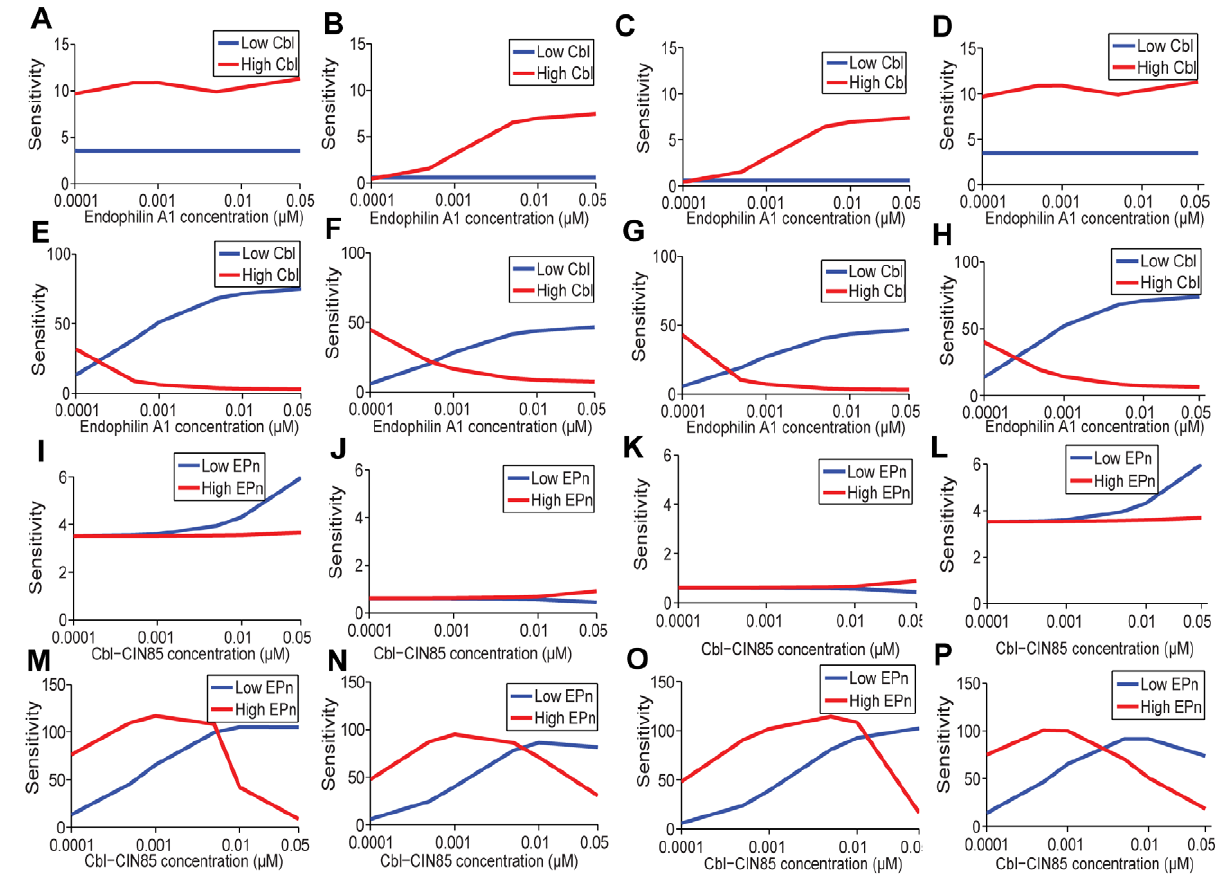
Figure 12. Detailed analysis on the sensitivities of activated ERK mediated by scaffold proteins KSR and MP1 and modulators Cbl- CIN85 and Endophilin A1 under various situations. Sensitivities of first and third panel (A, B, C, D, I, J, K, L) KSR-mediated and conventional; second and fourth panel (E, F, G, H, M, N, O, P) MP1-mediated subpathways toward EGF variation regulated by (A - H) Endophilin A1 concentration variation when Cbl-CIN85 is low (0.0001 m M) or high (0.8 m M); (I - P) Cbl-CIN85 concentration variation when Endophilin A1 is low or high at four conditions: (A, E, I, M) when both scaffolds are present in suboptimal ‘‘low’’ levels [KSR =0.02 m M, MP1 =0.02 m M]; (B, F, J, N) when both scaffolds are present in optimally ‘‘high’’ concentrations as determined earlier [KSR =0.3 m M, MP1 =0.3 m M]; (C, G, K, O) when KSR is present at ‘‘high’’ level